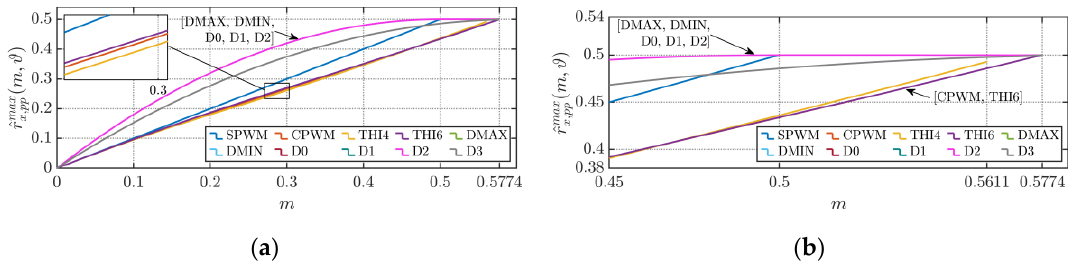
Figure 19. ( a ) Normalized maximum peak-to-peak value as a function of m for all the considered injections; ( b ) Magnification for high values of m .